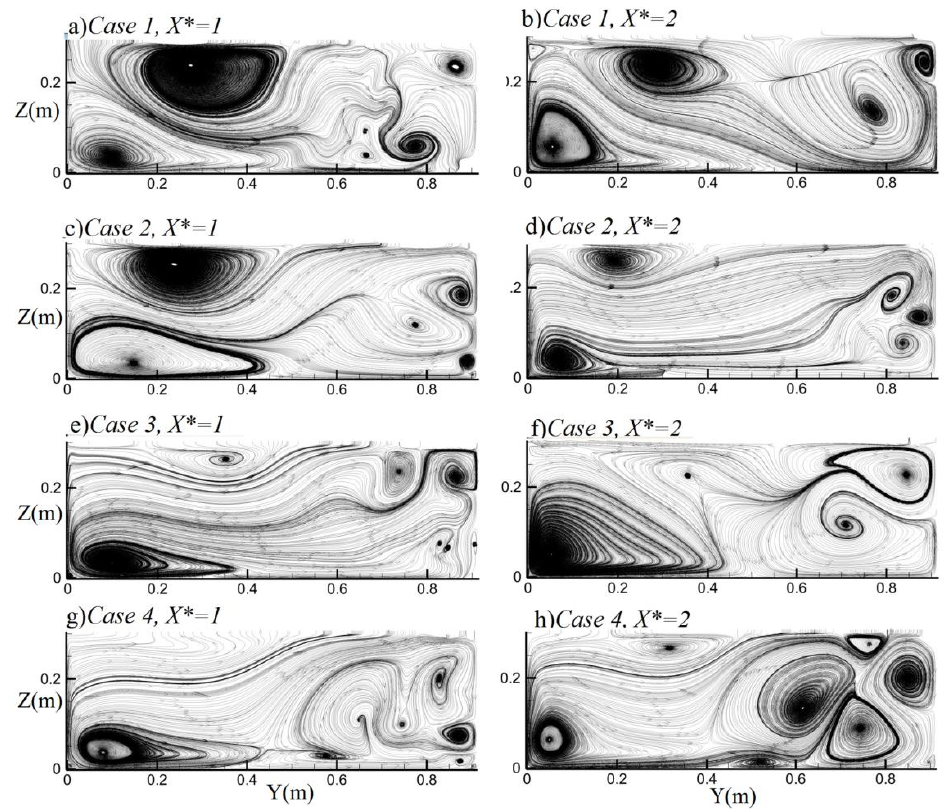
Figure 8. The effect of W* variations on the vertical structure in the transverse plane. Figure 8. The e ff ect of W* variations on the vertical structure in the transverse